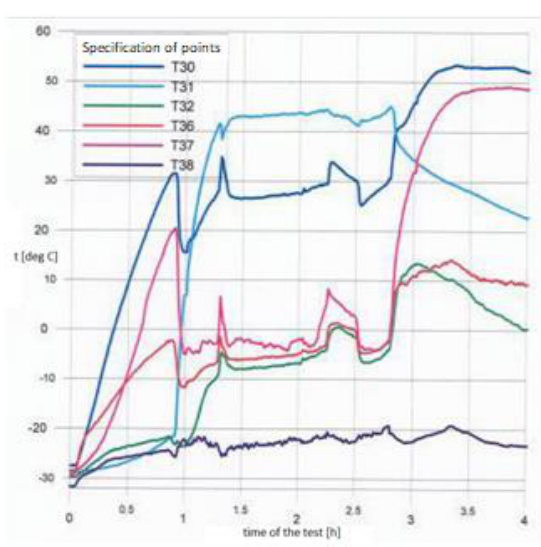
Fig. 9. The course of temperature change at selected points of the CI engine [12]